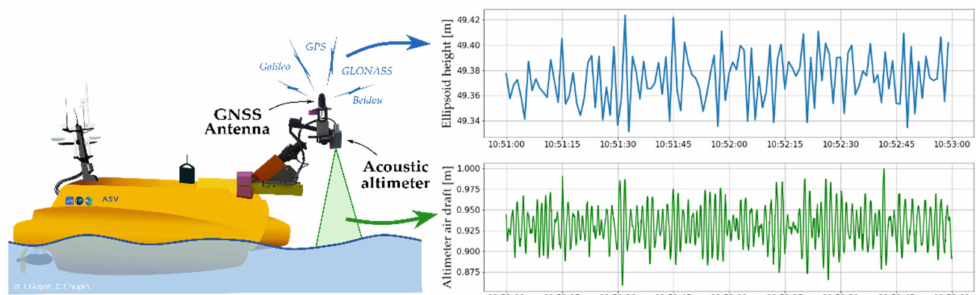
Figure 2. Mini-Cyclop é e measuring system used on PAMELi (USV). To continuously monitor the sea surface height, this sensor combines a geodetic Global Navigation Satellite Systems (GNSS), antenna with an acoustic altimeter which allows for air-draft corrections. The 1 Hz GNSS measurements are represented by the blue curve in the upper right panel, and the lower right panel show the 20 Hz acoustic altimeter